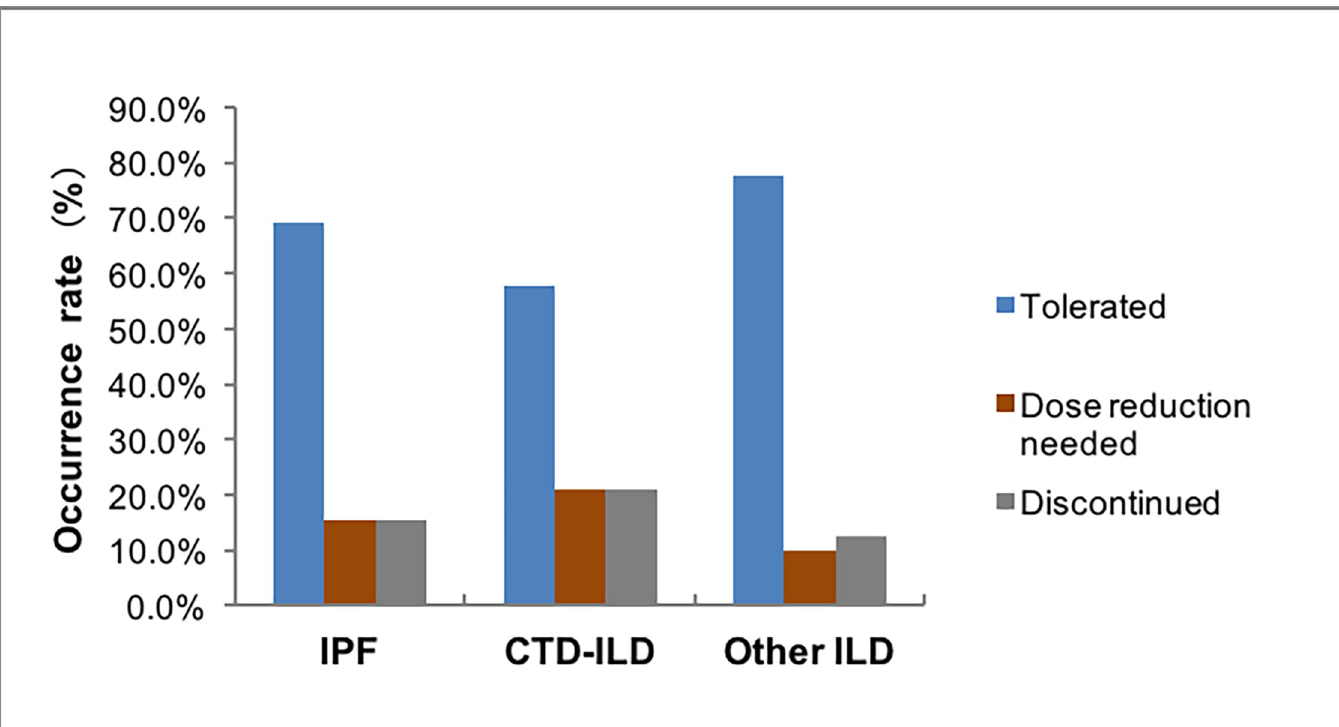
Fig 3. Tolerability to pirfenidone therapy.